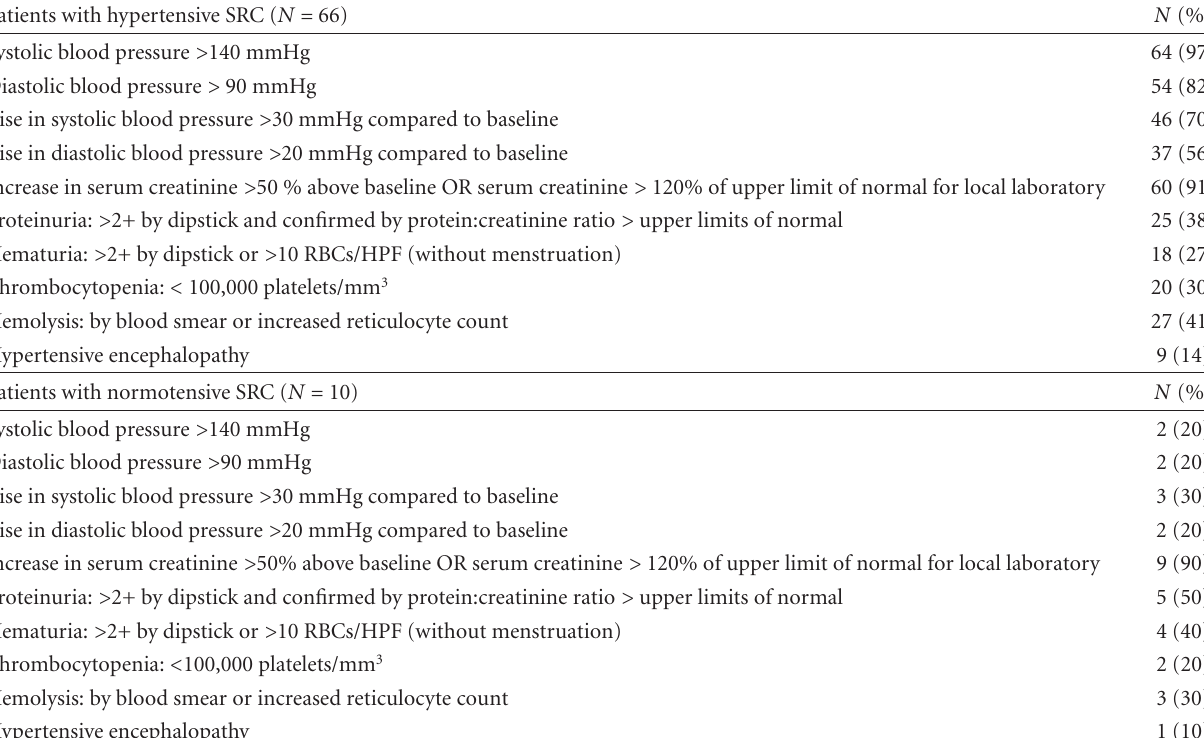
Table 3: Signs and symptoms of